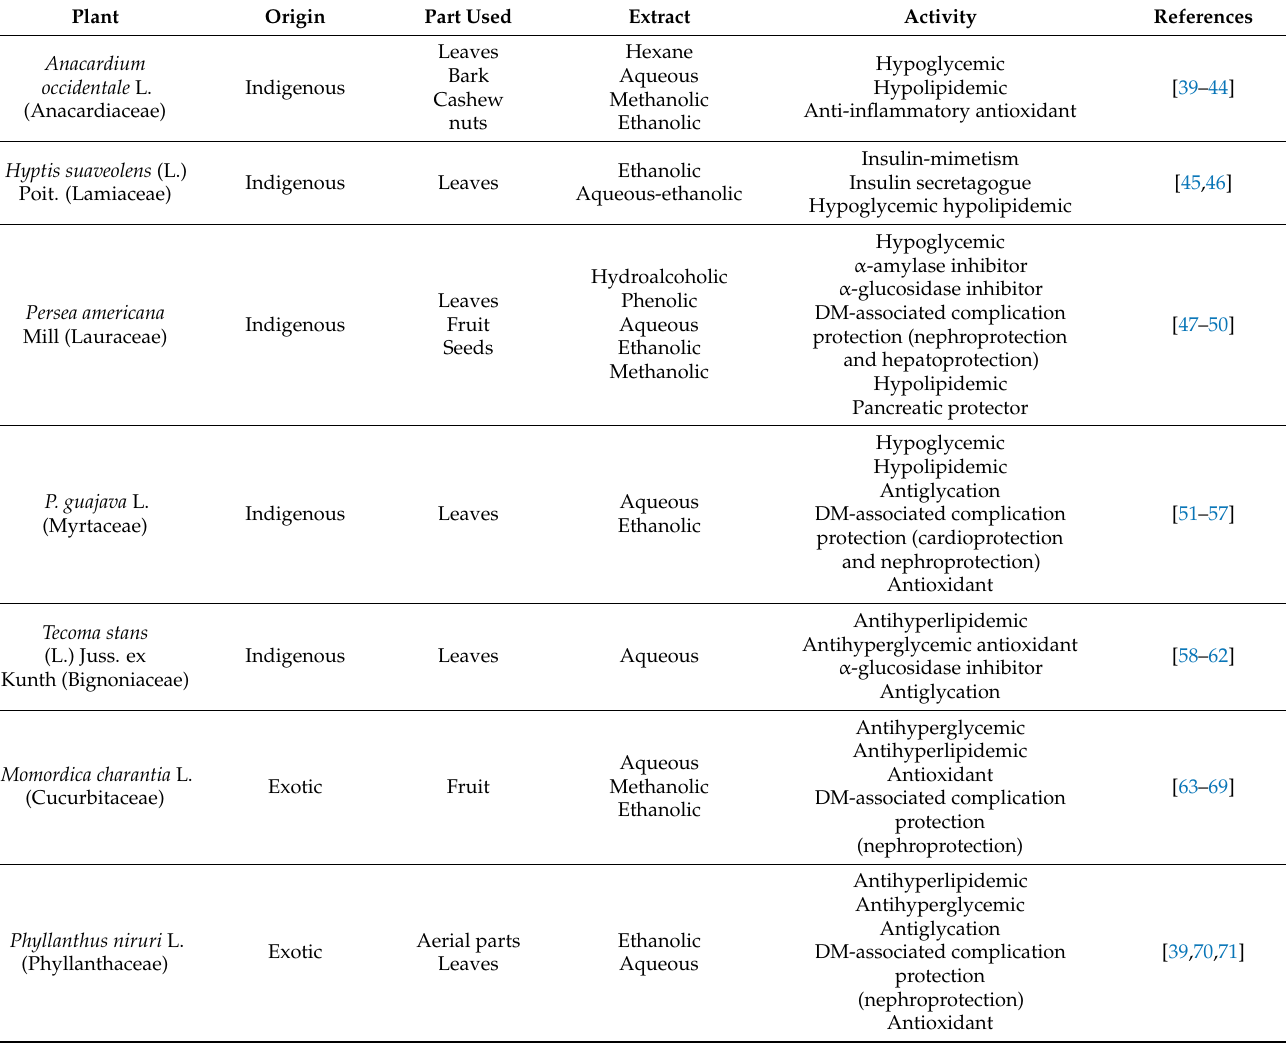
Table 2. General overview of plants from the Caribbean flora described in this review in which in vivo studies are available. Information about the origin, part of the plant used, type of extract, antidiabetic activity and references are